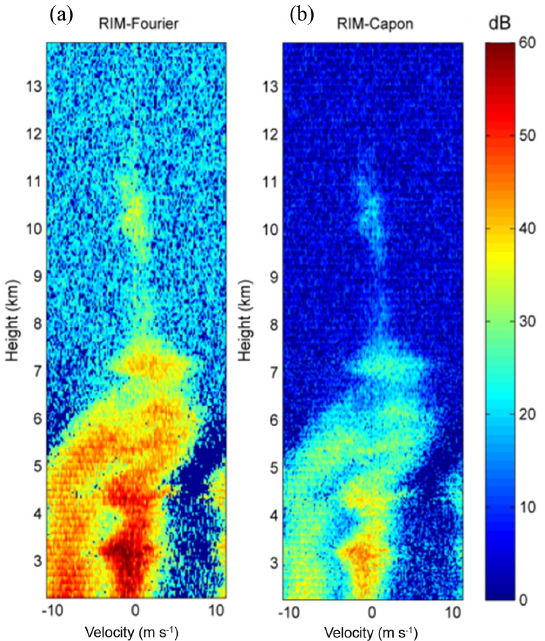
Figure 2. (a) Fourier RIM and (b) Capon RIM power spectra ob- tained with the temporal signals retrieved from the same radar data in Fig. 1. Imaging step is